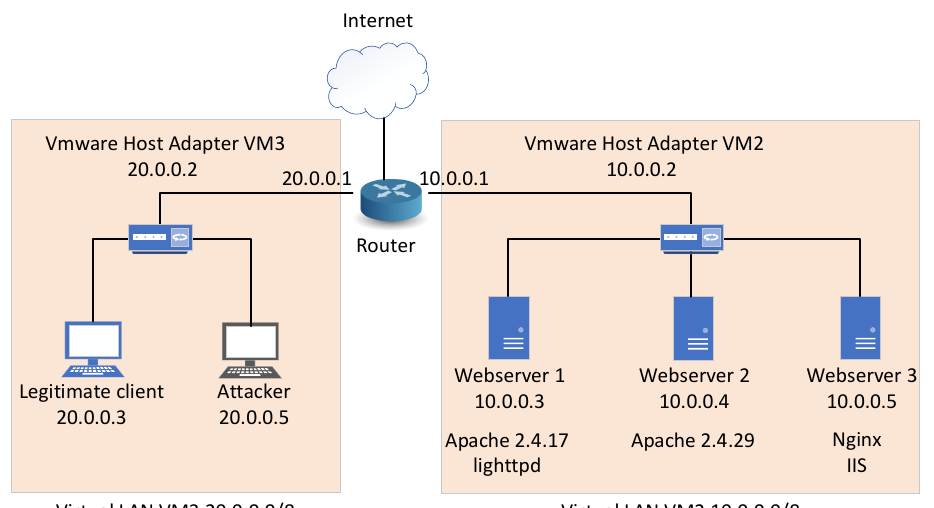
Figure 2. Experimental network